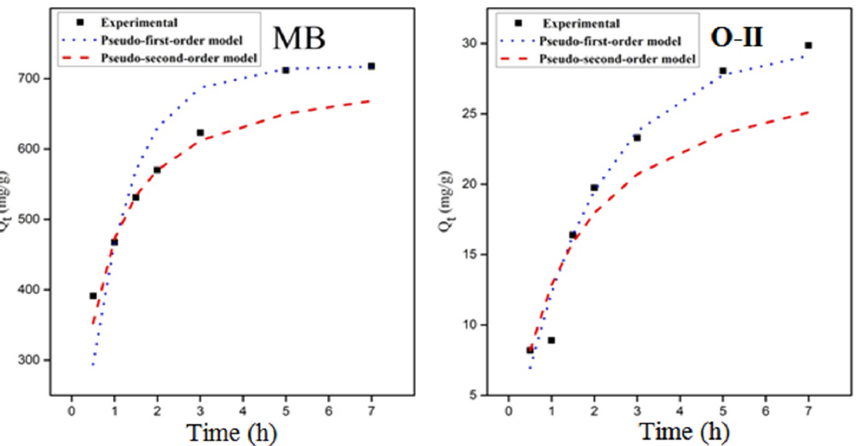
14 of 21 Table 1. The kinetic parameters of MB and O-II dye adsorption.